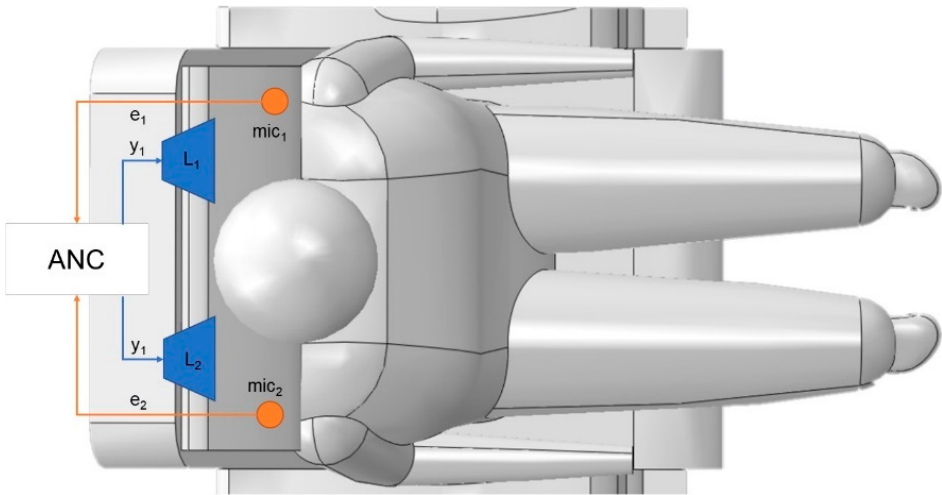
Figure 1. Active noise control from the cabin seat headrest.